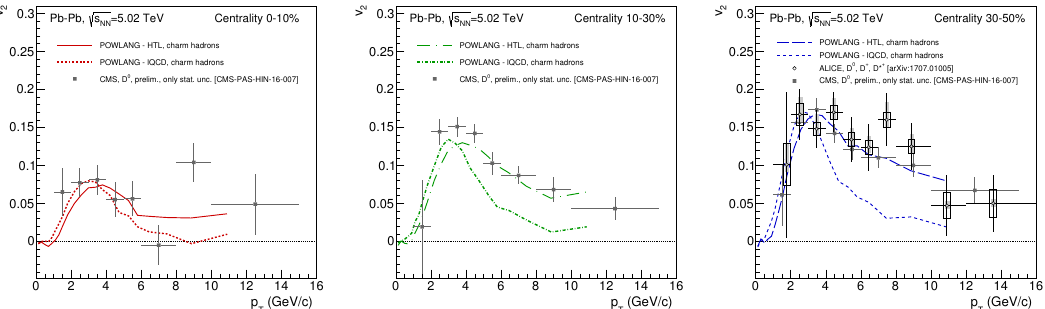
p s NN = 5 : 02 TeV, for various